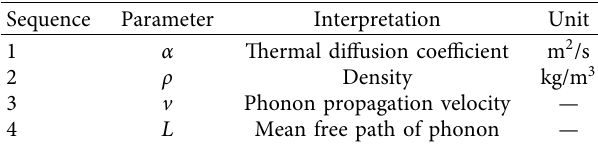
Table 4: Parameter definition in the formula. Sequence